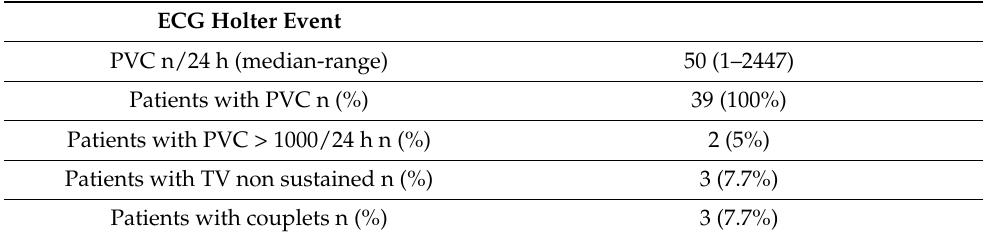
Table 2. Ventricular ectopic events on Holter ECG.